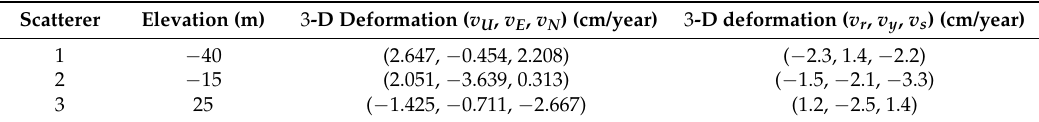
Table 3. Elevation and deformation parameters of